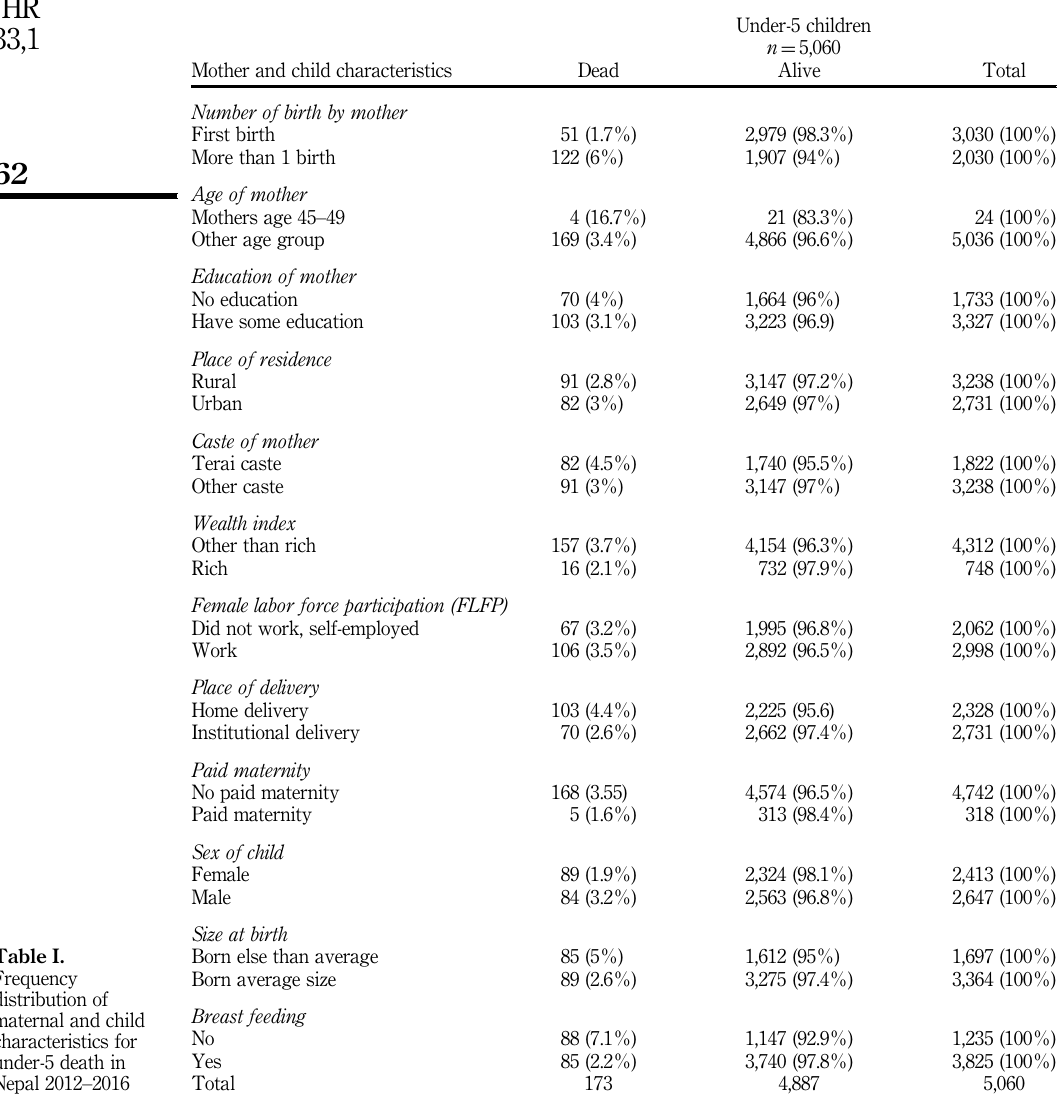
distribution of maternal and child characteristics for under-5 death